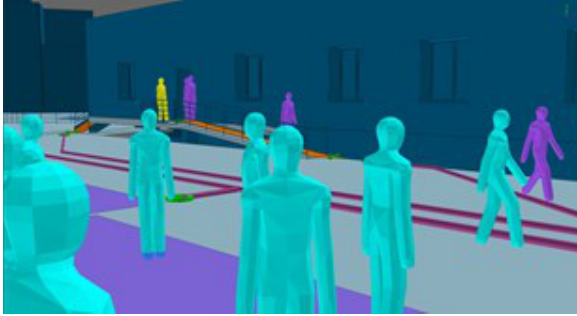
Figure 9: Simulation of the exit movement flow.